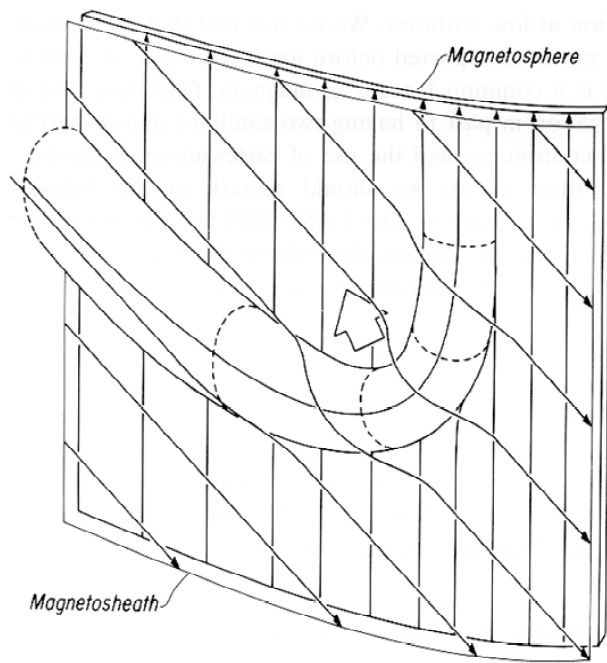
Fig. 1. A schematic configuration of magnetic field lines for Figure 1 the Flux Transfer Events (FTEs) on the northern side of the MPCL/LLBL, taken from Russell and Elphic (1978). The flux tube is formed by reconnection of the intrinsic geomagnetic field lines directed northward (upward in figure) with the magnetosheath (solar wind) magnetic field lines directed south-duskward (right- downward in figure). This flux tube is prominent to the direction normal to the MPCL surface and drapes around the magnetosheath magnetic field lines. In addition, it is moving poleward due to mag- netic tension force, shown by the thick open